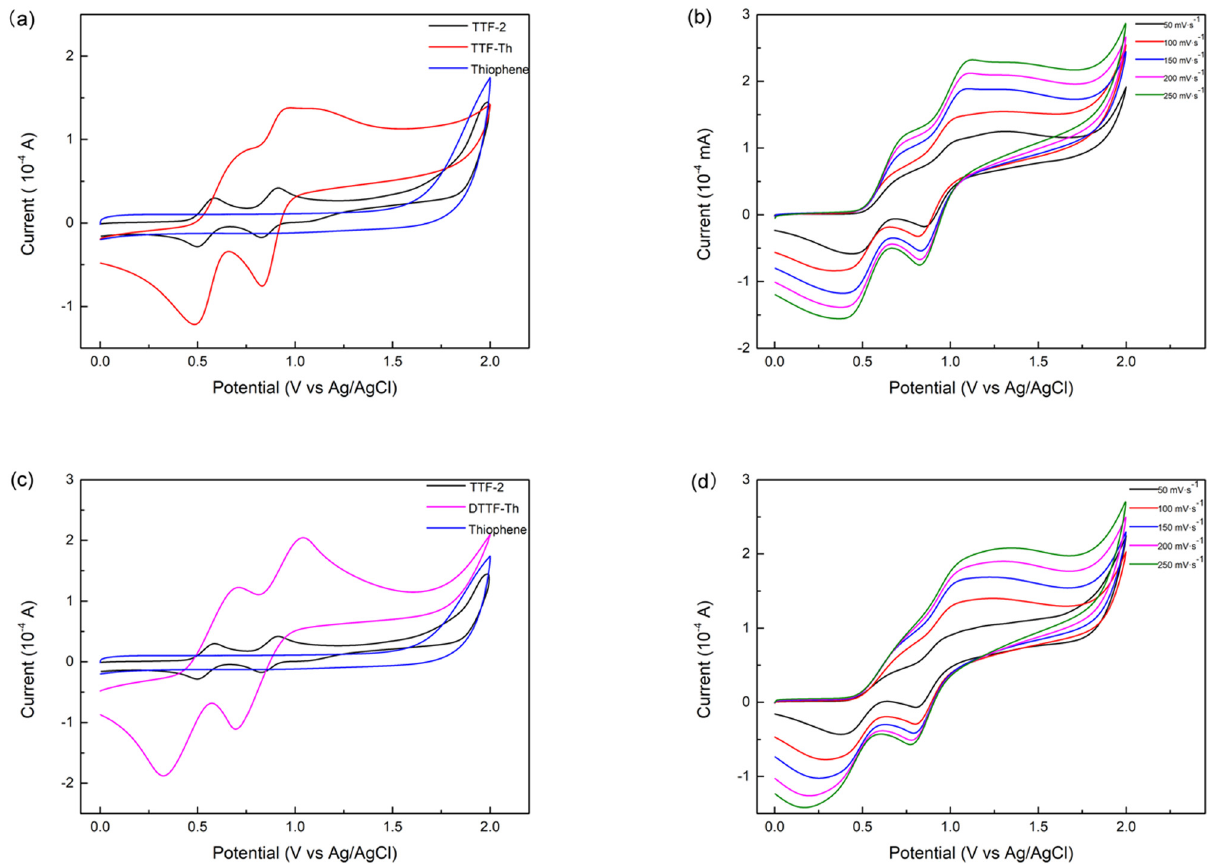
Figure 3: Cyclic voltammetry curves: ( a ) TTF - 2, TTF - Th, and thiophene; ( b ) TTF - Th at di ff erent scan speeds; ( c ) TTF - 2, DTTF - Th, and thiophene; and ( d ) DTTF - Th at di ff erent levels of scan speed.